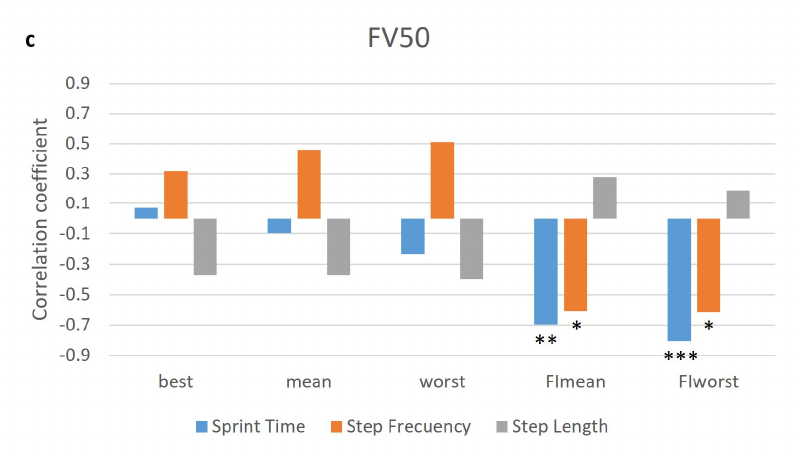
Figure 4. Relationships (r) between ( a ) CMJ, ( b ) CMJ50, and ( c ) FV50 and the best, mean, worst, FImean, and FIworst parameters of step kinematics during the RSA test. Statistical correlation at p < 0.05 (*), p < 0.01 (**) or p < 0.001